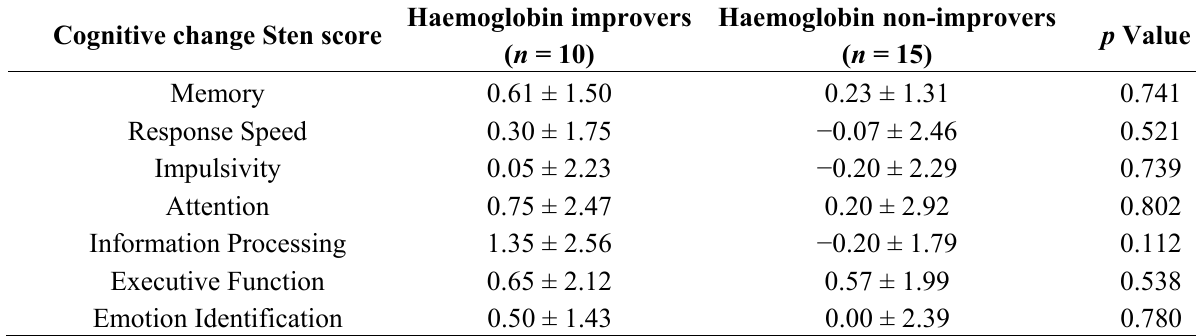
Table 4. Cognitive domain change scores for haemoglobin improvers and